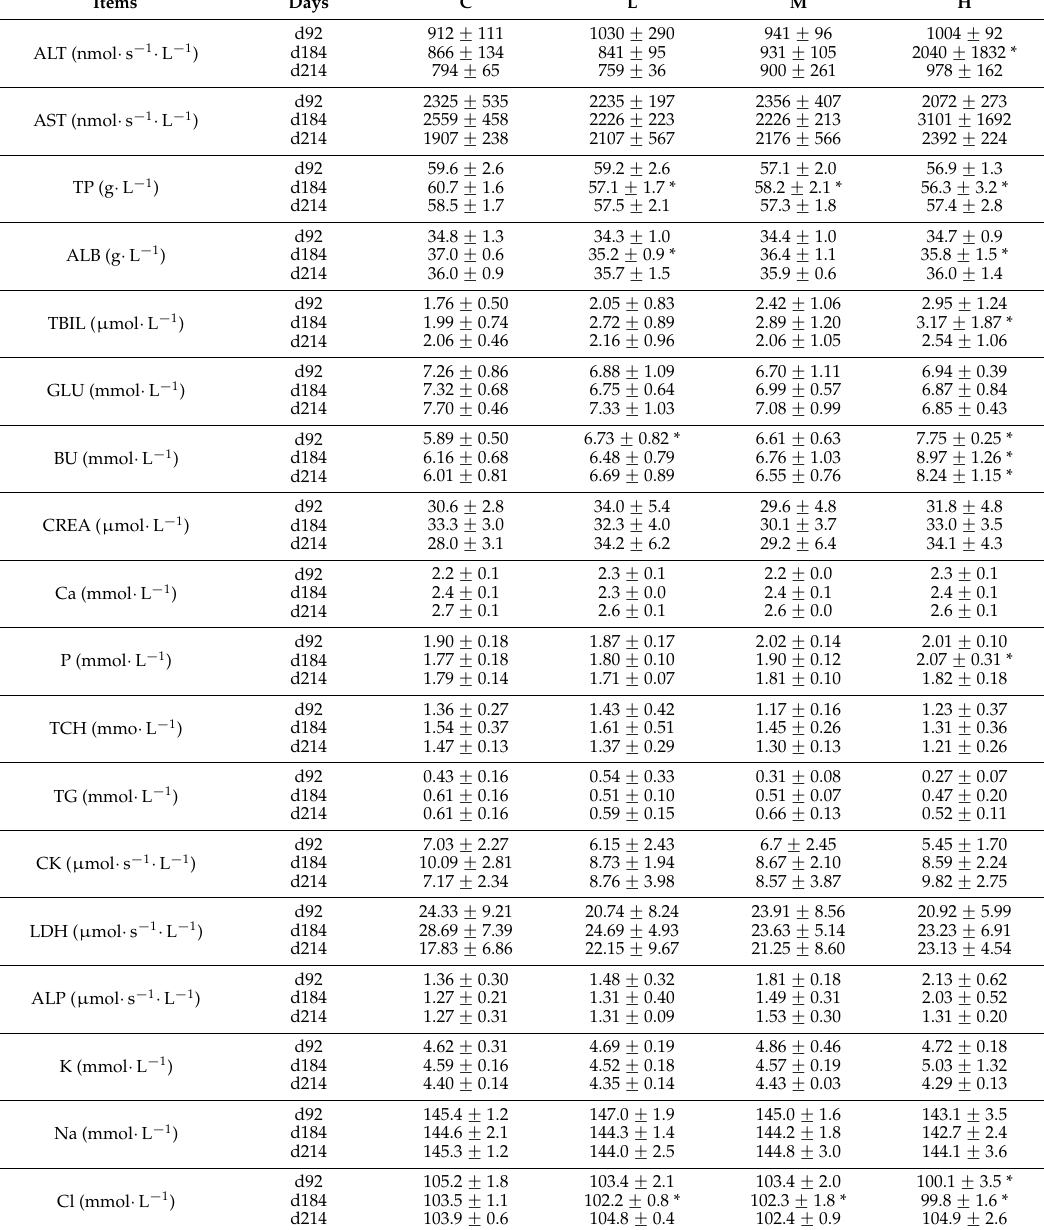
– x ˘ SD, d92 n = 5, d184 n = 10, d214 n =